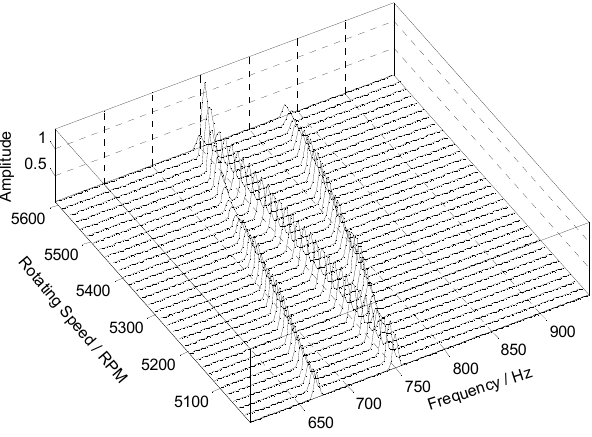
Figure 17. Waterfall of the angular-domain reconstruction signal using two non-uniform BTT sensors under VRS.